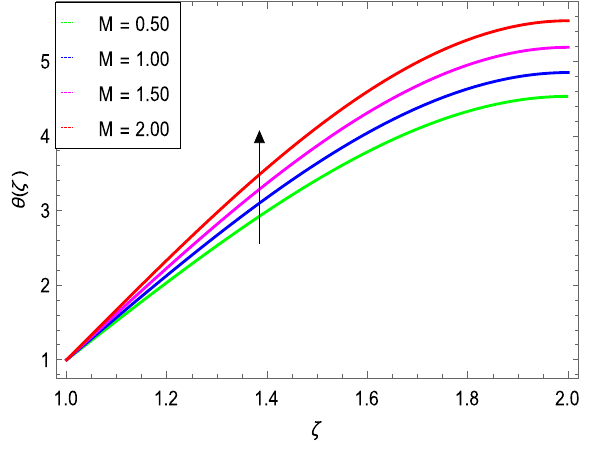
Figure 8. θ (ζ) as a function of M .